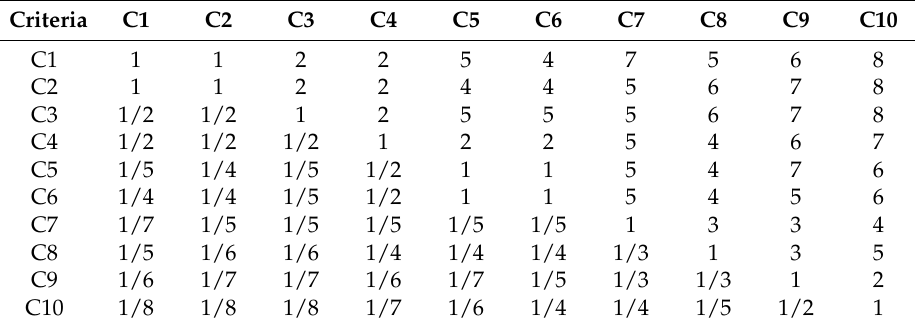
Table 7. Double comparison matrix of the criteria according to the Saaty